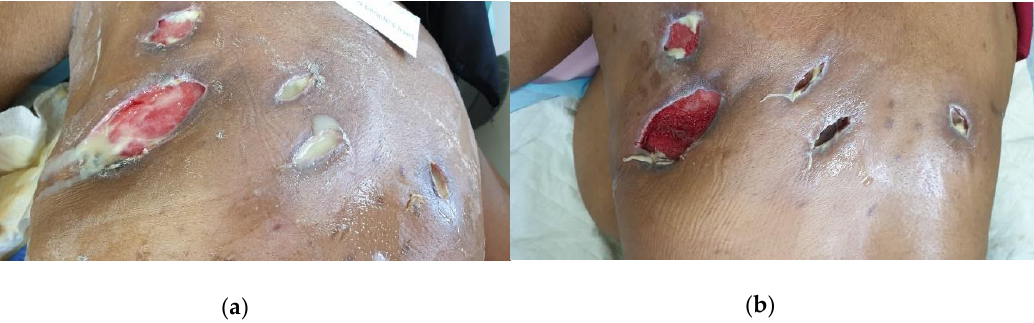
Figure 3. Clinical Case 2 with a massive Pseudomonas - and Staphylococcus -infected abscess on the back, of which the cavities were filled with L-Mesitran Soft as treatment. ( a ) Picture at the start of L-Mesitran Soft treatment on Day 0. ( b ) Clear wound progression after three dressing changes and one week of treatment.